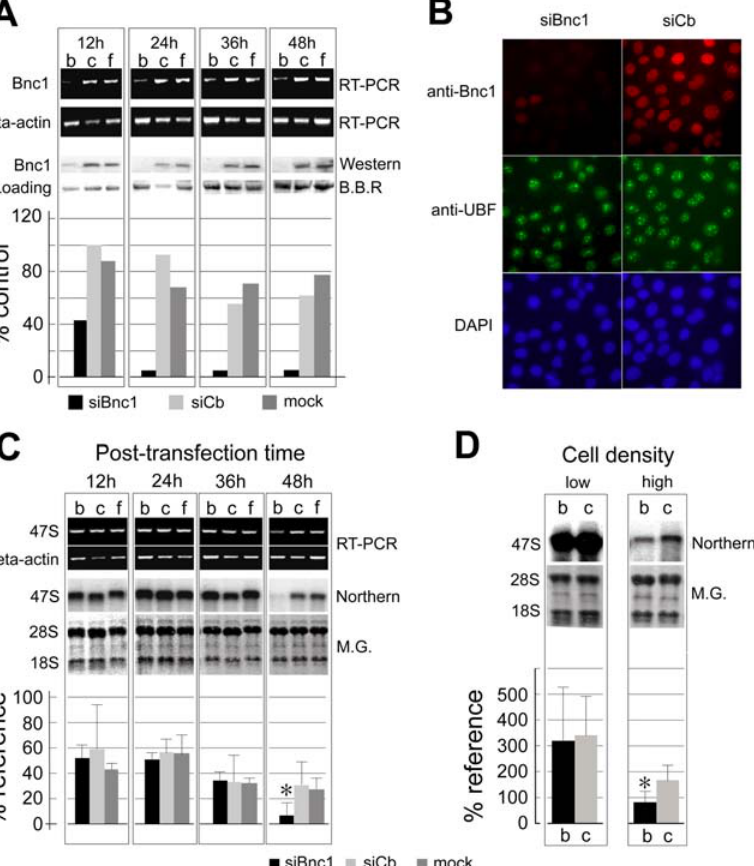
Figure 2. Inhibition of basonuclin expression via siRNA reduces pre-rRNA level in the HaCaT cells. A , HaCaT cells were transfected with siRNA and controls. b, siBnc1 targeting siRNA, c, control siRNA, f, mock transfection (Lipofectamin only). Basonuclin mRNA and protein levels were monitored by PCR and Western blot at four post-transfection time points, 12, 24, 36 and 48 hours. No difference among the experimental groups was detected at 0 h (not shown). A beta-actin RT-PCR served as a control for the quantity and quality (integrity) of RNA. A protein band detected by Brilliant Blue R (B.B.R) was chosen as a loading control because of its consistent quantity in cells receiving different treatments. The protein levels shown in the Western blot were quantified in relation to the loading control (histogram). B , Immunocytochemical staining of transfected cells. HaCaT cells were cultured in chamber slides and transfected with siBnc1-s and siCb-s. Cells were fixed at 48 h post-transfection and stained with anti-basonuclin (anti- Bnc1) and anti-UBF antibodies simultaneously. Microscopic photographs in each column represent the same field, visualized by different secondary antibodies, basonuclin, red (cy5), UBF (FITC) and DNA (DAPI). C , Effect of basonuclin siRNA on the level of 47S pre-rRNA. 47S pre-rRNA was measured by RT-PCR or Northern analysis, with beta-actin and mature rRNA as references, respectively. HaCaT cells were seeded at 1.5 6 10 5 cell/35 mm dish and transfected after cells were attached. RNAs were prepared at post-transfection 12, 24, 36 and 48 hours. The treatment groups b, c, and f are as described in ( A ). The results of Northern analysis was quantified in relation to methylene-green-stained mature rRNA (histogram), n=3. Note